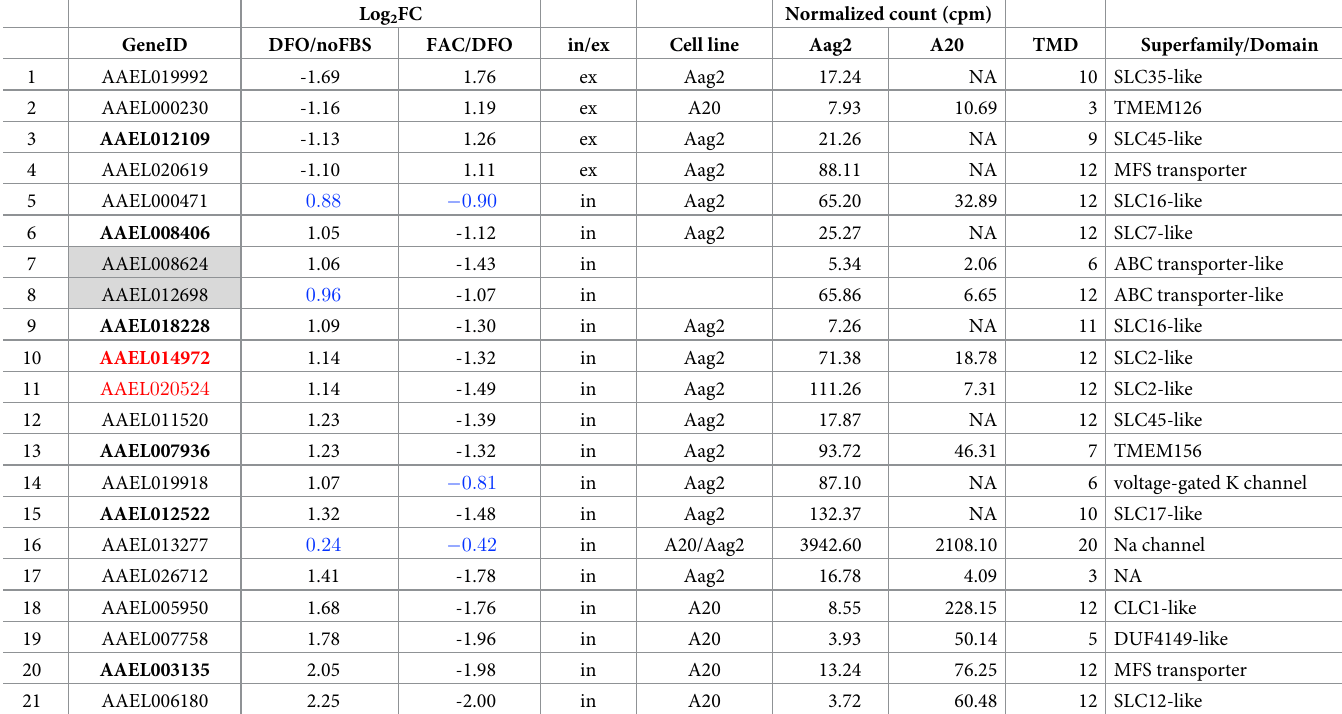
Table 1. Candidate iron transporter genes selected from RNAseq data. GeneID: VectorBase gene ID. Log 2 FC: log 2 fold change between indicated comparison groups. in/ex: predicted iron transporting function; in: importer, ex: exporter. Cell line: cell line used for dual-luciferase reporter assay; AAEL013277 was used for both cell lines as the expression was high in both cell lines. Normalized count: normalized CPM (counts per million) for the two cell lines. There was only one dsRNA available for AAEL014972 and AAEL020524 (red fonts) due to high identity between these genes. AAEL008624 and AAEL012698 (grey-shaded) could not be analyzed downstream due to failure of synthesizing dsRNA. Genes in bold fonts are present in both the candidate tables from AaegL3 and AaegL5 assemblies. TMD: number of predicted trans- membrane domains. Blue fonts in Log 2 FC indicates values lower than threshold in AaegL5 mapping, but higher in AaegL3 mapping. Superfamily/Domain: Predicted superfamily/domain by blastp. SLC: solute carrier. TMEM: transmembrane protein. MFS: major facilitator superfamily. ABC: ATP binding cassette. CLC: chloride chan- nel. DUF: domain of unknown